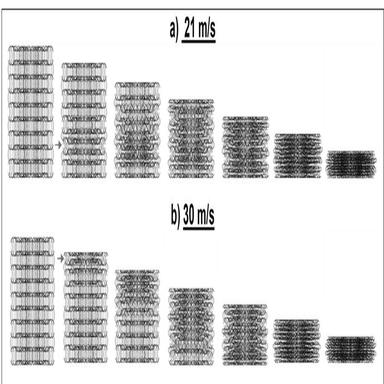
The simulation of the deformation behaviour of the ACS_V1.